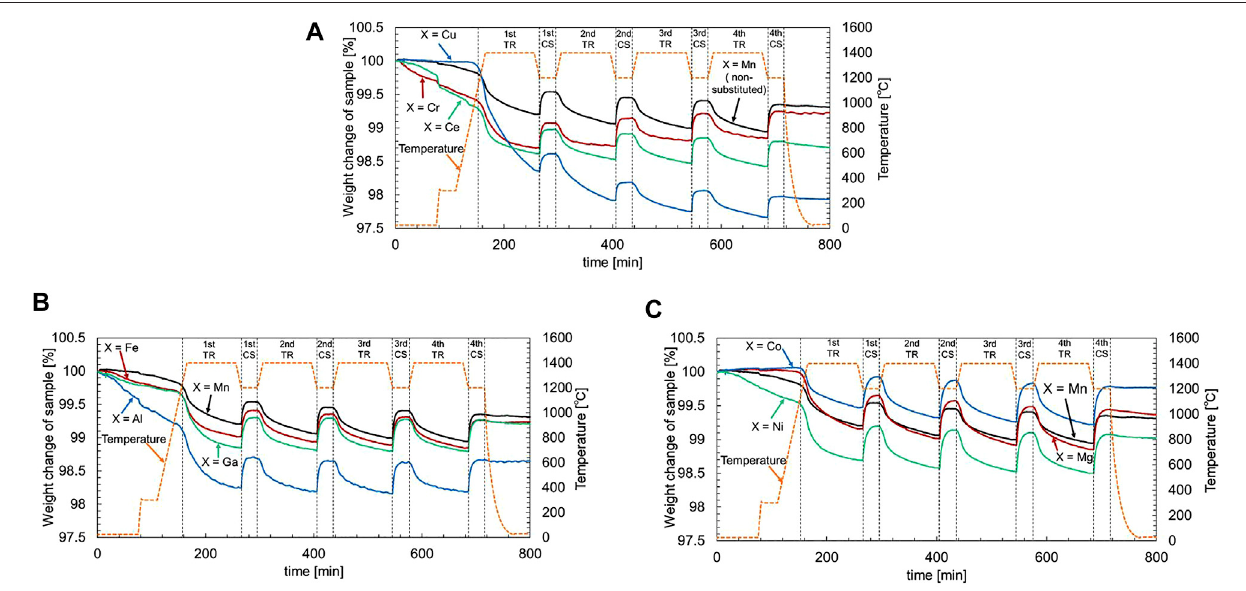
FIGURE 2 | TGA pro fi les of the weight change in the activity tests of two-step thermochemical CO 2 splitting using La 0.7 Sr 0.3 Mn 0.9 X 0.1 O 3 sample powder [X = (A) Cu, Cr, and Ce-substituted LSMs, (B) Fe, Al, and Ga-substituted LSMs, and (C) Co, Ni and Mg-substituted LSMs]. Forcomparison, TGA pro fi le ofMn (non-substituted LSM) is plotted in the fi gure. To eliminate adsorptive species on the surface of the sample powder, the sample powder was fi rst heated at 300 ° C for 0.5-h at a rate of 50 K/min using an electric furnace while passing 99.999% high-purity nitrogen gas through the reactor at a fl ow rate of 100 cm 3 /min at standard state. Subsequently, the activity tests were continuously repeated four times under the same condition to evaluate the